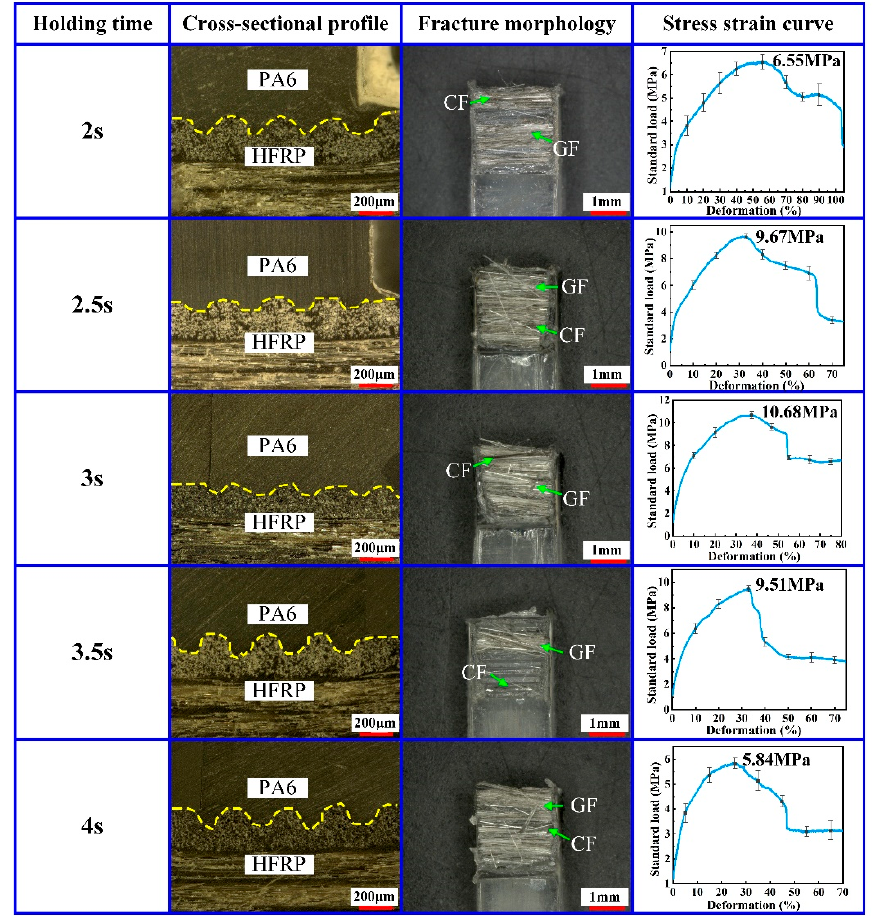
Figure 6. Effect of holding time on the injection molding quality of the composite part.